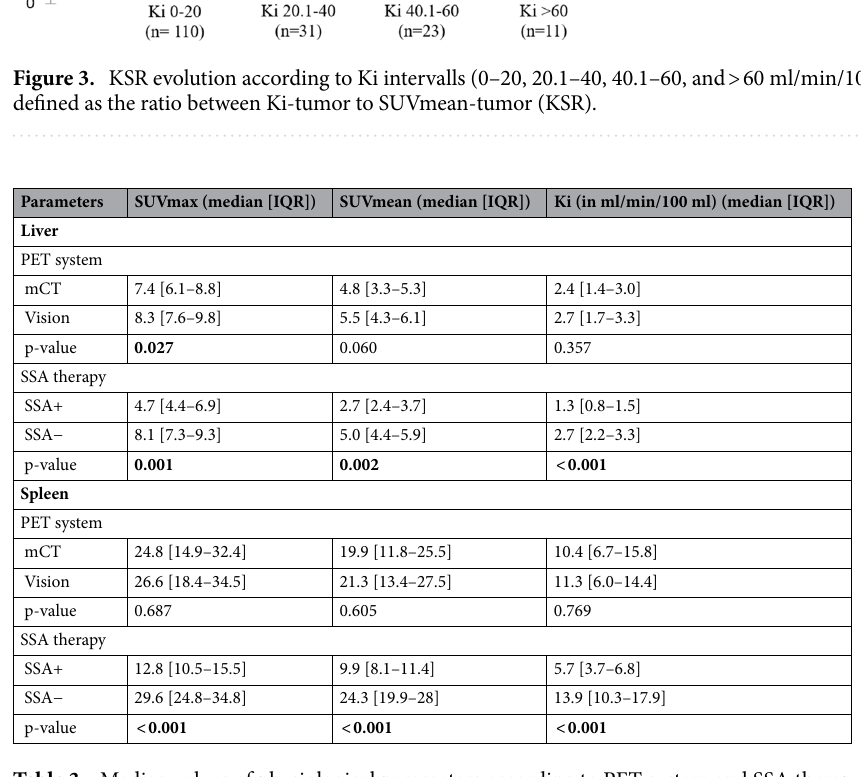
Table 3. Median values of physiological parameters according to PET system and SSA therapy. Bold characters corresponded to p value <0.05